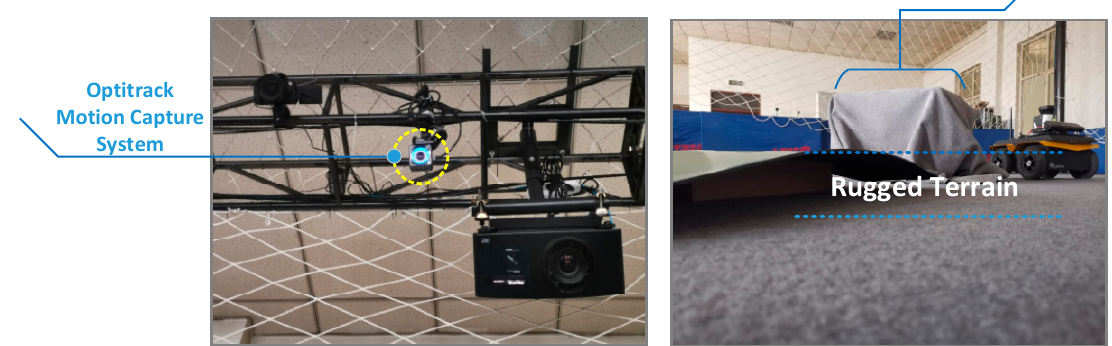
Figure 17. The indoor verification environment.